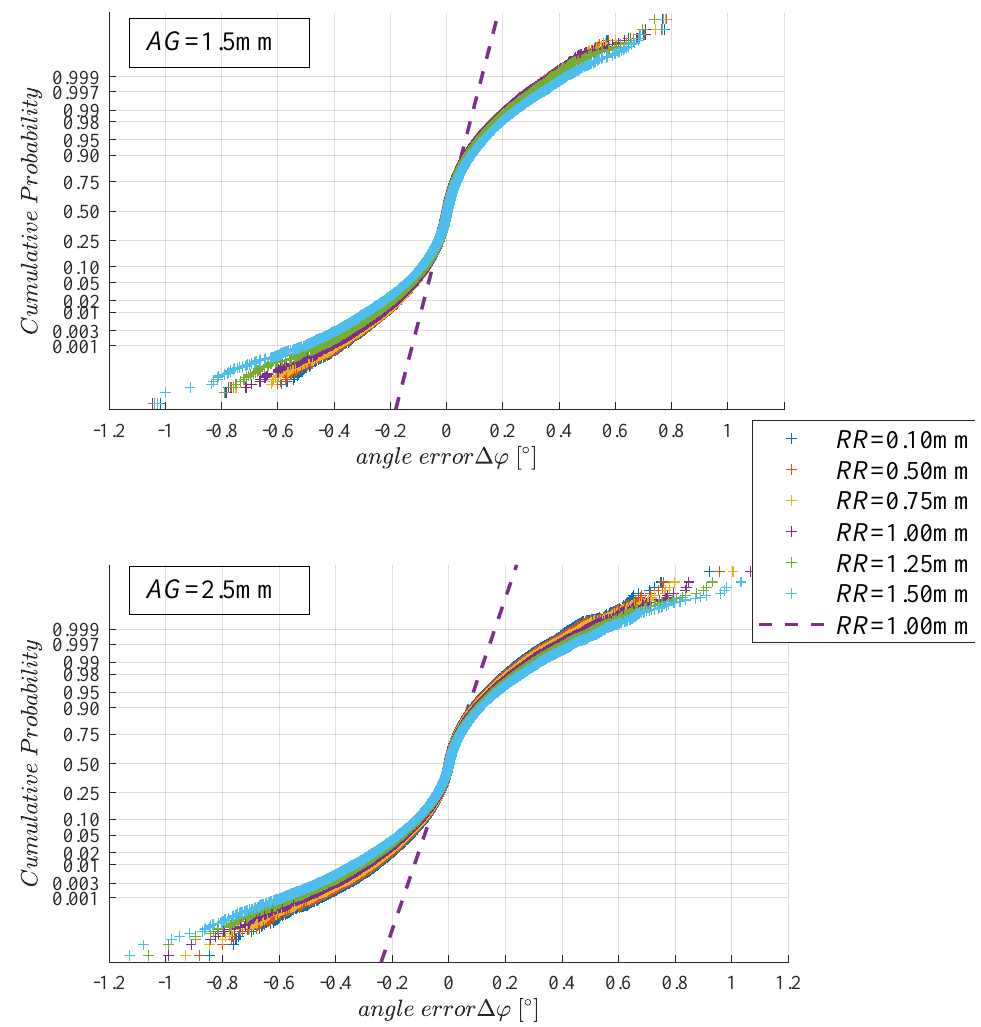
Figure 3. Cumulative probability distribution of the angle error ∆ ϕ at the rotation angle ϕ = 33.75 ◦ for various reading radii RR at an air gap AG of ( a ) 1.5 mm and ( b ) 2.5 mm. Magnet parameters: D = 6 mm and H = 2.5 mm. Assembly tolerances are according to Table 2. The dashed straight line denotes a Gaussian distribution with equal average and standard deviation. Note to legend: “+”: Monte Carlo simulation; “- - -”: Gaussian distribution with the same standard deviation as Monte Carlo simulation for RR = 1 mm; 100,000 Monte Carlo runs per